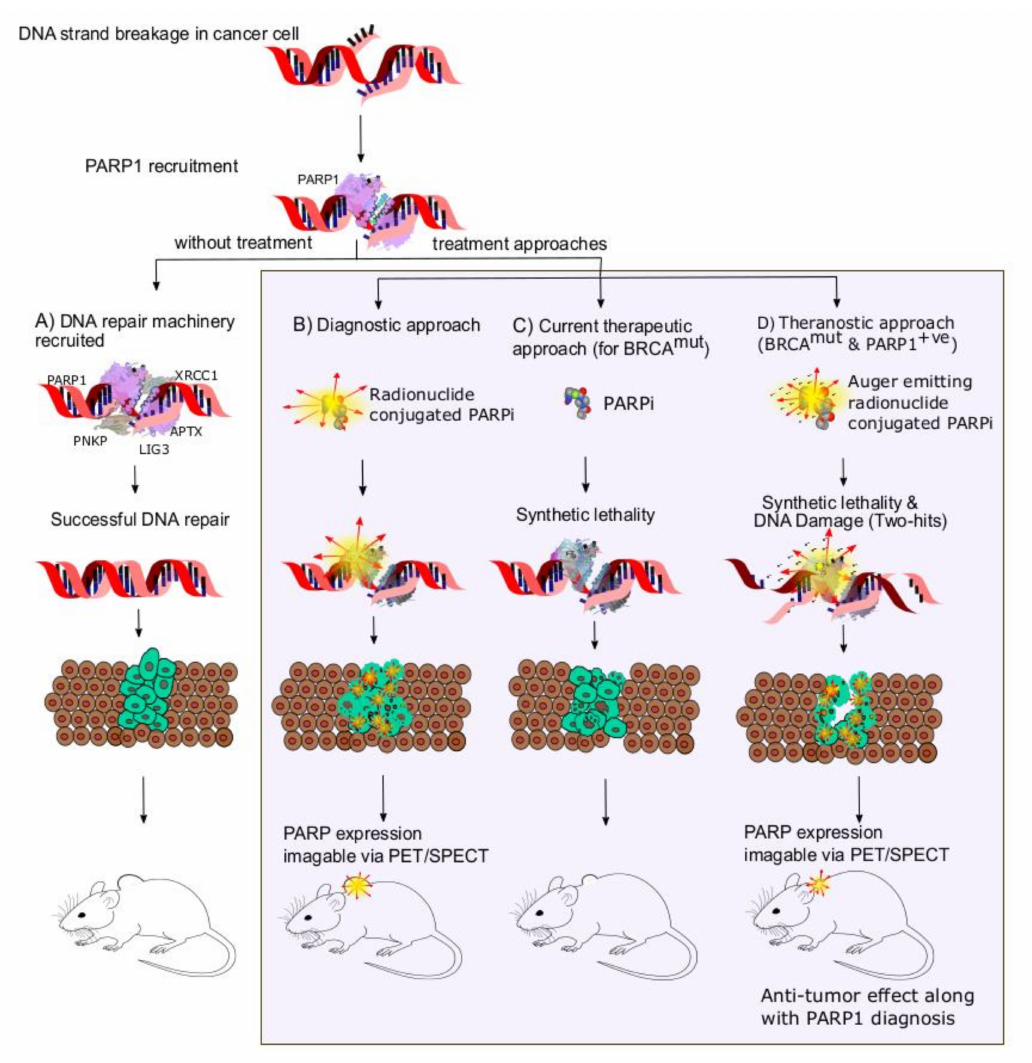
Figure 1. Schematic representation of PARP1-targeted therapy and imaging approaches. ( A ) Upon no treatment, PARP1-mediated repair enables cancer cell proliferation and tumour growth. ( B ) PET / SPECT radionuclide-conjugated PARP inhibitors enable imaging of the tumour tissues and PARP1-expression levels. ( C ) PARP inhibitor-based targeted therapy causes "Synthetic lethality", thereby inhibiting DNA repair mechanisms. ( D ) Auger electron (displayed in picture), Beta or Alpha particle-emitting radionuclides are able to cause DNA damage apart from synthetic lethality, and functions as a "two-hit" strategy and enhances apoptosis of cancer cells. For optimal synthetic lethality, supplementation with PARP inhibitors would be